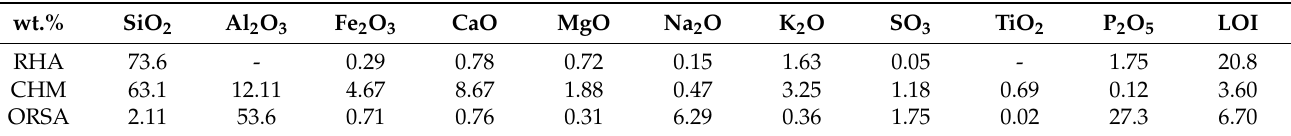
Table 1. Chemical composition of raw materials. Rice husk ash (RHA), chamotte (CHM) and oil refining sludge ash (ORSA).